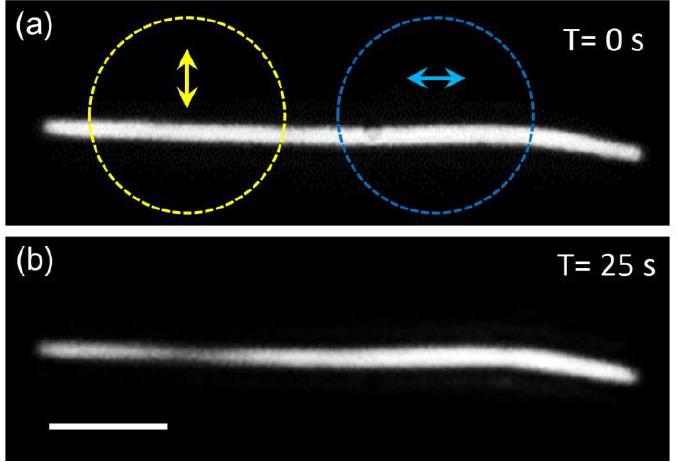
Figure 3. NW etching with different excitation polarizations. ( a ) Dark field image of an Ag NW. The dashed circles indicate laser spots with polarization of perpendicular (yellow), and parallel (blue). ( b ) Dark field image of the NW in ( a ) after etching. The scale bar is 5 μm. The illumination time is 25 s.